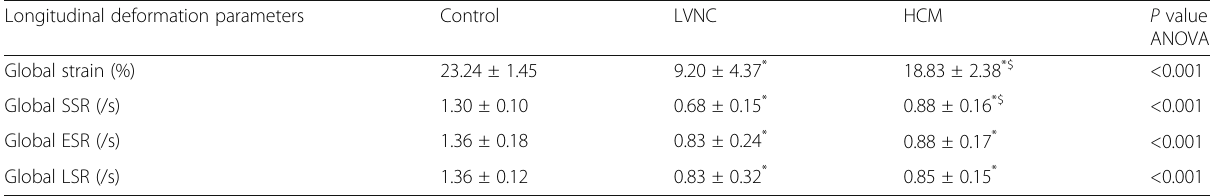
Table 2 Longitudinal deformation parameters in LVNC, HCM, and controls Longitudinal deformation parameters Control